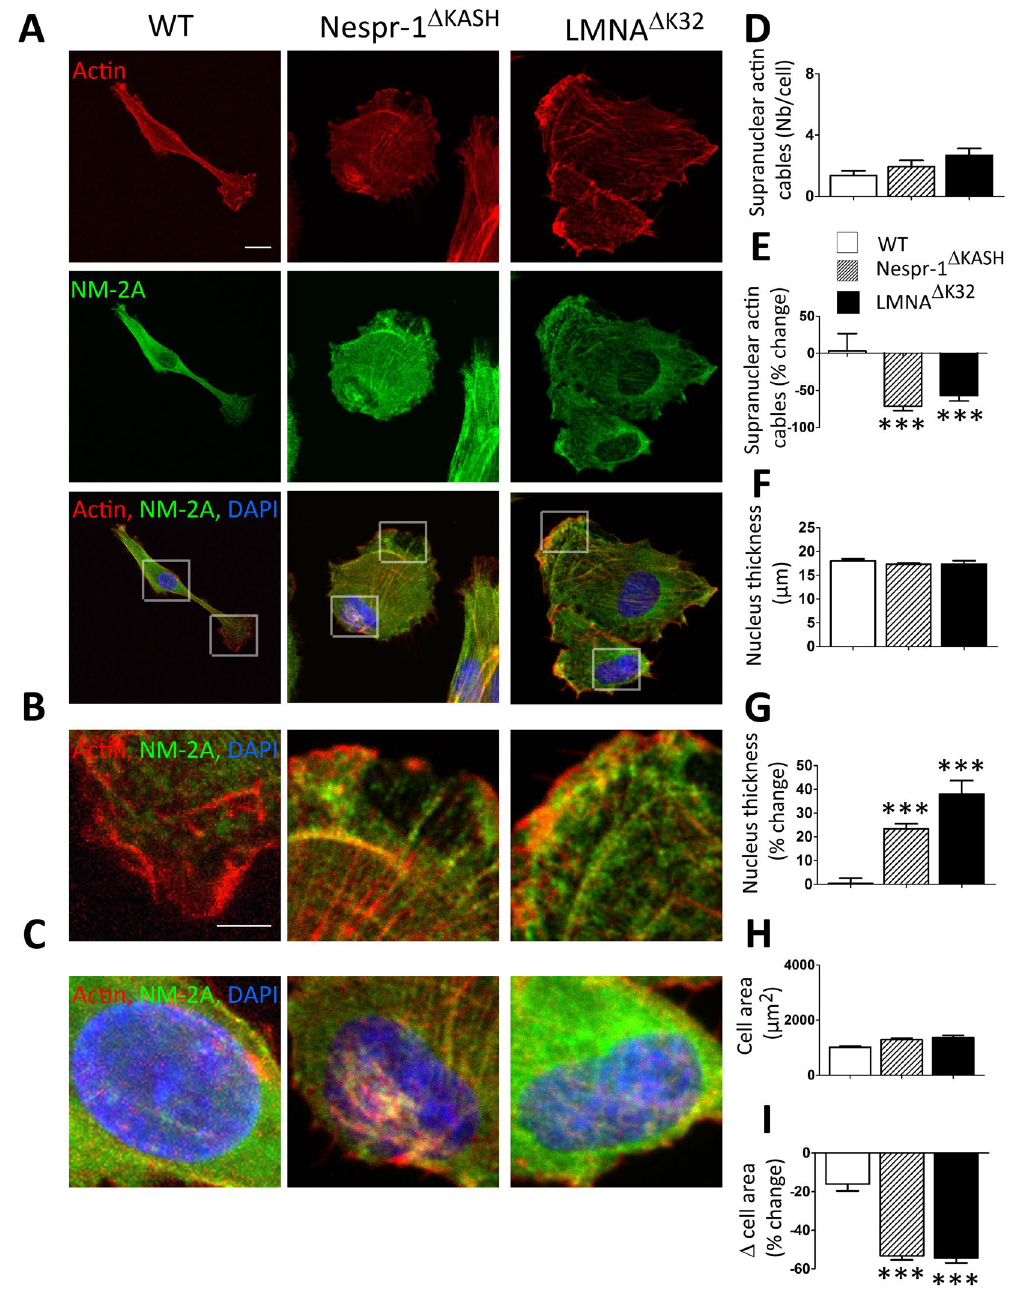
Figure 6. siRNA against FHOD1 reduced actin contractility and nucleus thickness in myoblasts on soft matrix (12 kPa). ( A ) Confocal images of WT, Nespr-1 Δ KASH and LMNA Δ K32 myoblasts on soft matrix and stained for F-actin (phalloidin, red) and NM-2A (green) after siRNA against FHOD1. Scale bar: 10 µ m ( B , C ) Zoom-in of actin cytoskeleton at cell periphery ( B ) and in the perinuclear regions ( C ). Scale bar: 10 µ m. ( D , E ) Supranuclear actin cable number in WT, Nespr-1 Δ KASH and LMNA Δ K32 myoblasts after siRNA against FHOD1. Values are expressed as absolute numbers ( D ) and as percent of baseline values for each cell line ( E ). Values are means ± SEM, n ≥ 19 in WT, Nespr-1 Δ KASH and LMNA Δ K32 myoblasts, *** p < 0.001 compared to values before siRNA against FHOD1. Only significant difference is figured. ( F , G ) Nuclear thickness in WT, Nespr-1 Δ KASH and LMNA Δ K32 myoblasts after siRNA against FHOD1. Values are means ± SEM. n ≥ 19 in WT, Nespr-1 Δ KASH and LMNA Δ K32 myoblasts, *** p < 0.001 compared to values before siRNA against FHOD1. Only significant difference is figured. ( H , I ) Cell spreading area in WT, Nespr-1 Δ KASH and LMNA Δ K32 myoblasts after siRNA against FHOD1. Values are expressed as absolute values ( H ) and as percent of baseline values for each cell line ( I ). Values are means ± SEM, n ≥ 50 cells in each line; *** p < 0.001 compared to values before siRNA against FHOD1. Only significant difference is